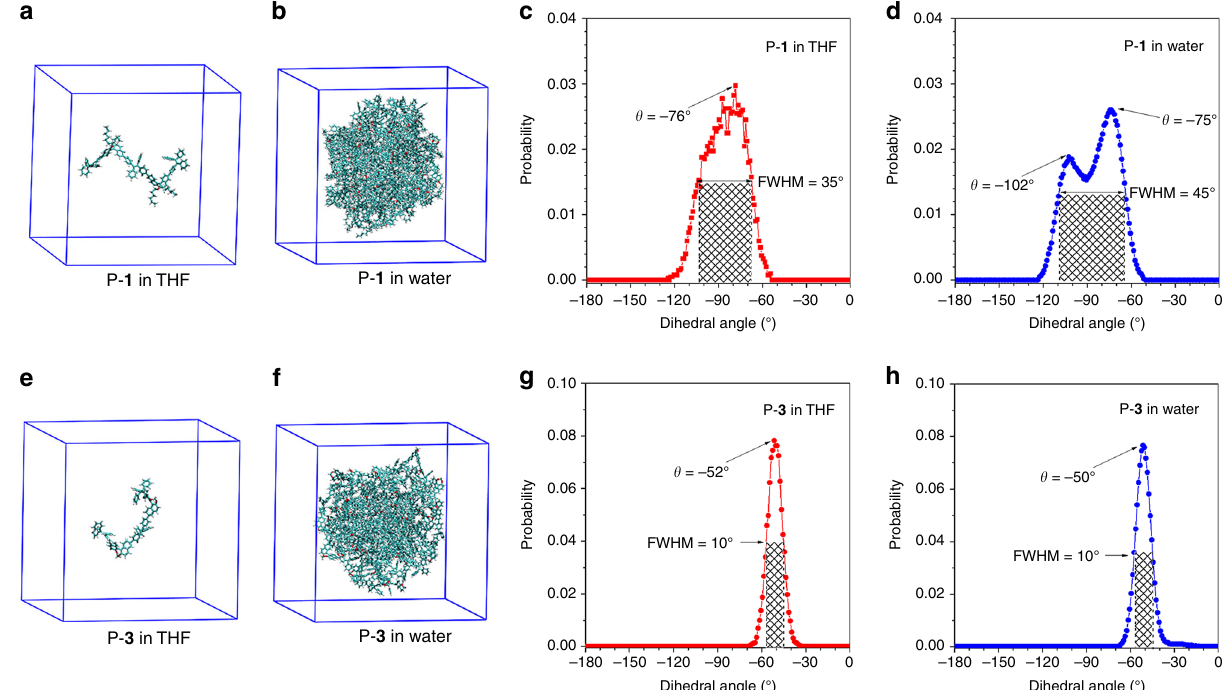
Fig. 5 The atomistic models of P- 1 and P- 3 in molecular dynamics simulations. a , e Show single P- 1 and P- 3 molecules in THF solution. b , f Show 30 P- 1 and P- 3 molecules aggregated in water solution. For clarity, the solvent molecules for THF and water are not shown here. c , d Show the relative Boltzmann populations of torsion angle θ in various conformers of P- 1 in THF and water, respectively. g , h Show the relative Boltzmann populations of θ in various conformers of P- 3 in THF and water, respectively. FWHM = full width at half